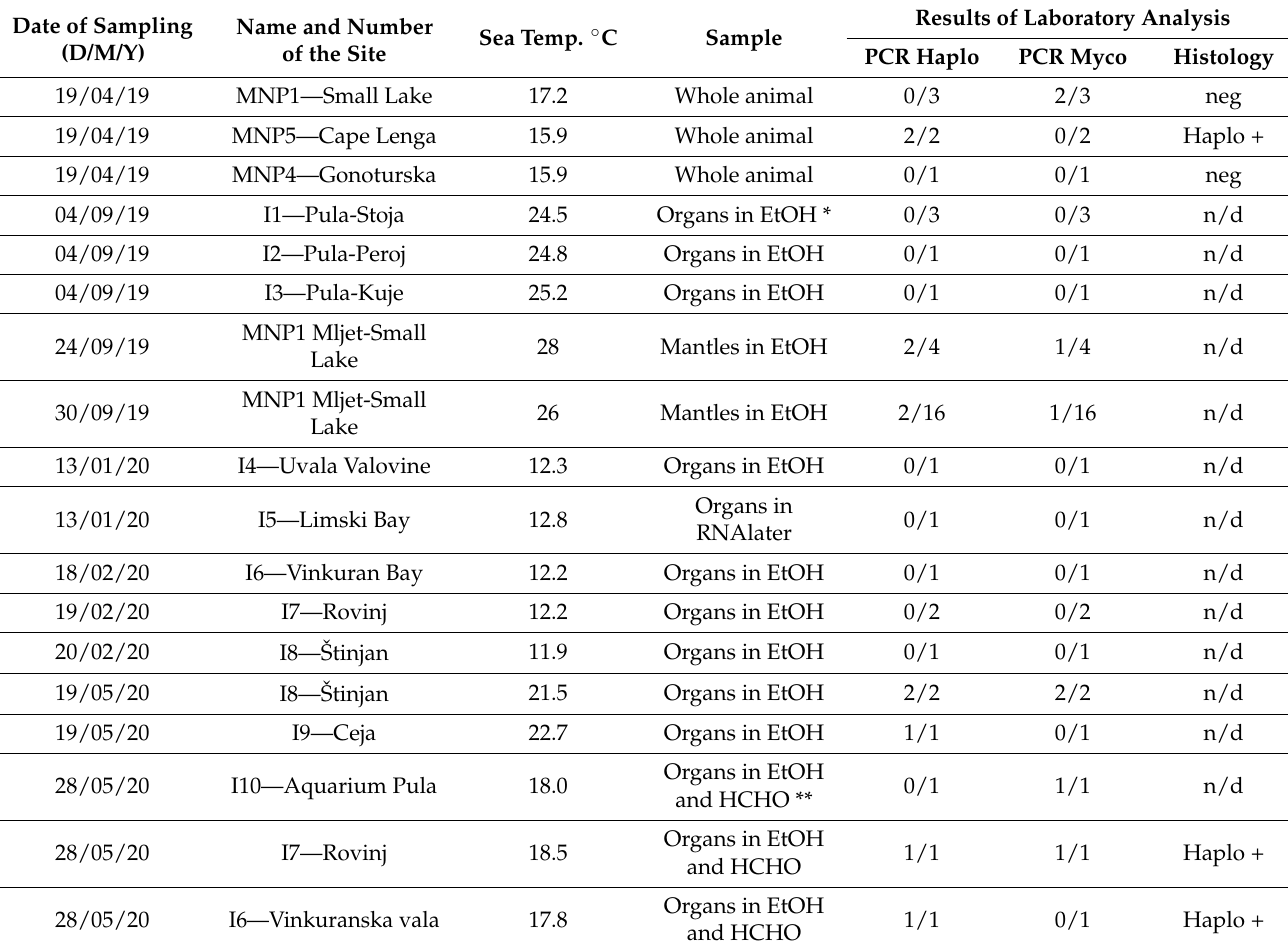
Table 1. List of sampling points and samples collected during 2019 and 2020, which were analyzed using PCR for detection of Haplosporidium spp. (Haplo) and Mycobacterium spp. (Myco) and using